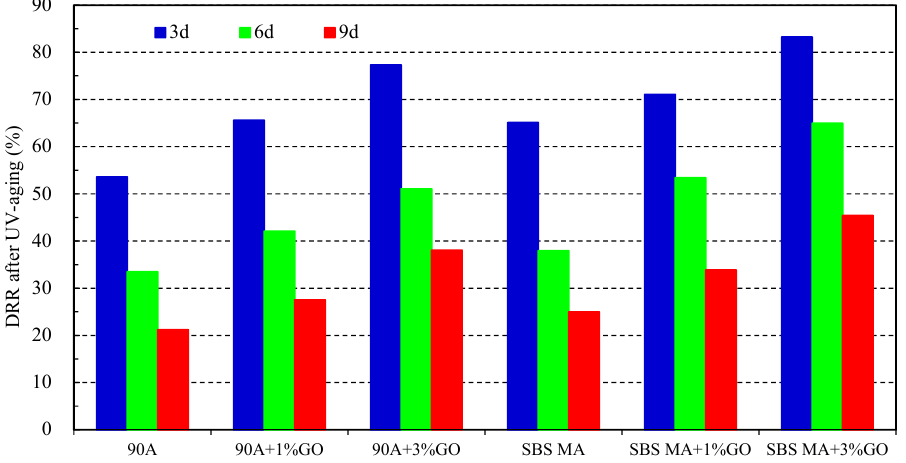
Figure 6. DRR of asphalt after UV aging.